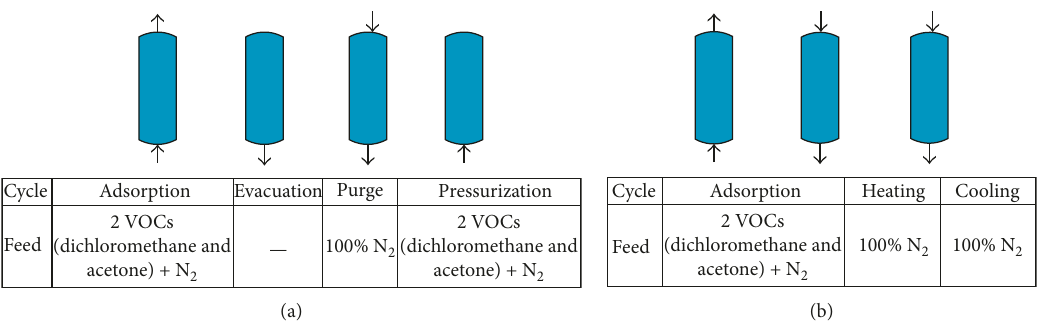
Figure 2: Schematic diagram and sequence of cycle steps in the operation of (a) 1-bed/4-step VSA cycle; (b) 1-bed/3-step TSA cycle for 2 VOCs